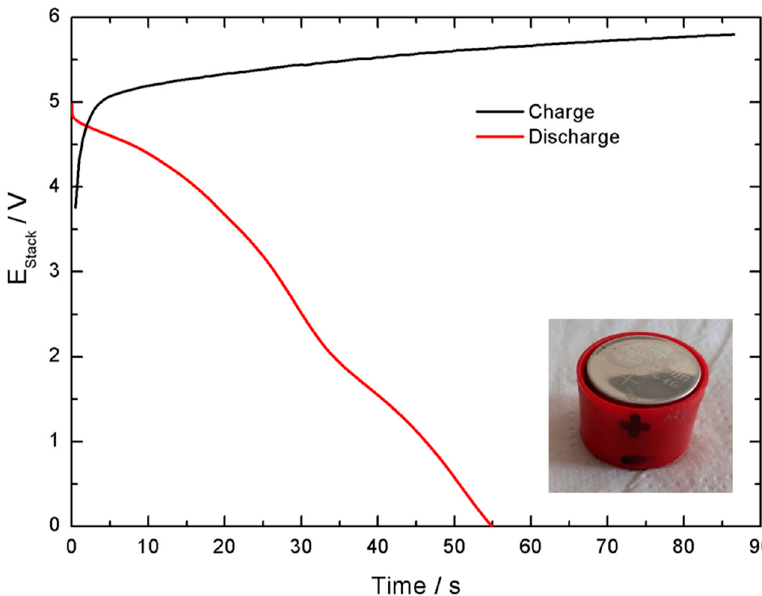
Figure 18. Galvanostatic charge-discharge results obtained at 1 mA cm − 1 . The inset includes an image of a final stack measured.